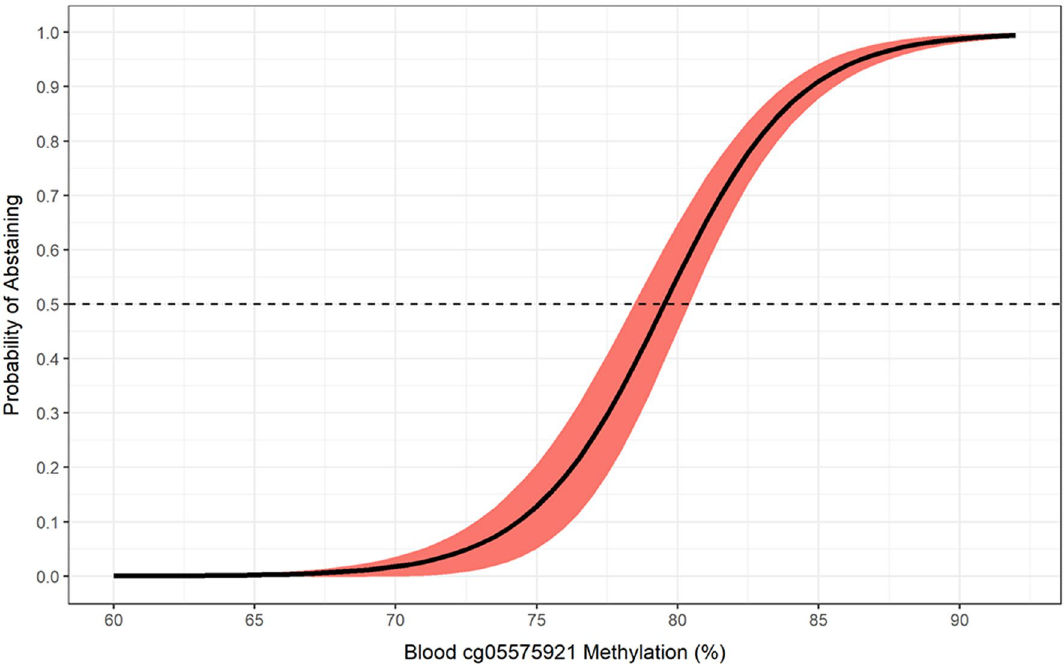
Figure 4. Predicted probability (95% confidence ribbon) of abstaining from smoking as a function of whole blood cg05575921 methylation percentage.